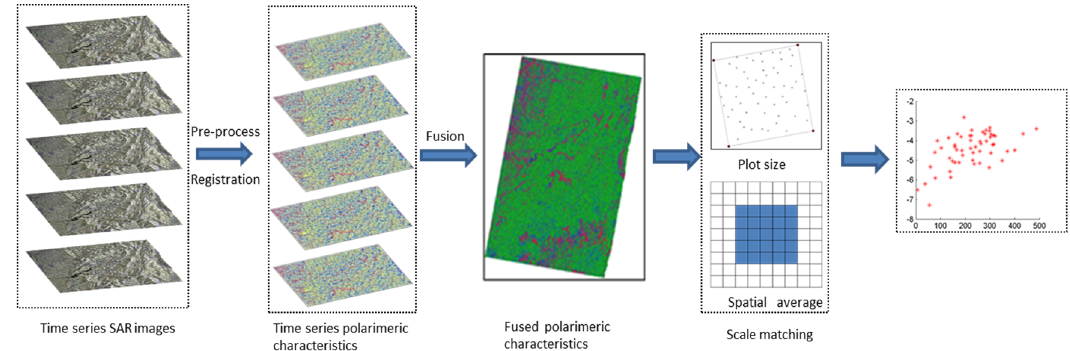
Figure 3. Flowchart of extracting polarimetric characteristics from the time series SAR images.